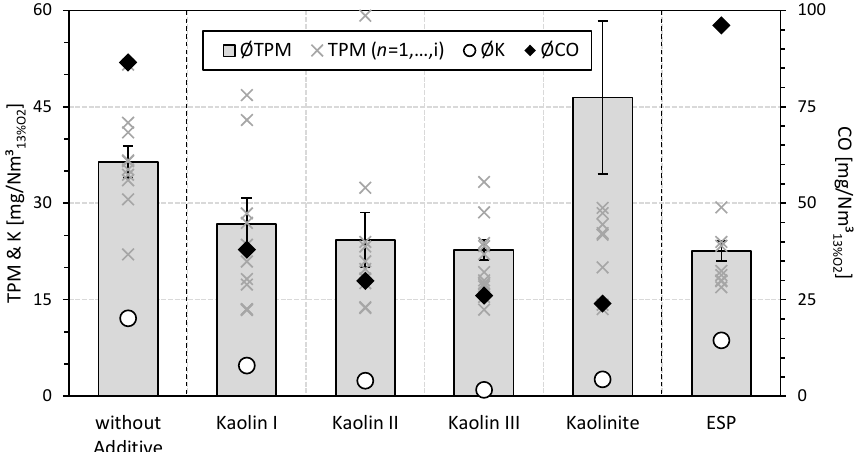
Figure 2. Mean total particulate matter (TPM) (individual measured values ( n ≤ 12) and standard errors), potassium and carbon monoxide emissions for the combustion of non-additivated (without and with electrostatic precipitator (ESP)) and additivated (0.5 wt% Kaolin I, Kaolin II, Kaolin III, and Kaolinite) wood chips (K: potassium, CO: carbon monoxide) .